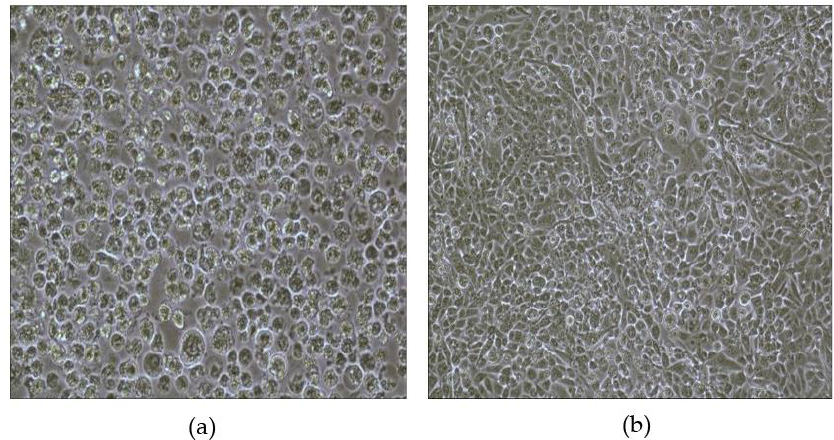
Figure 1. ( a ) RD cells with CPE; ( b ) normal RD cells; absence of CPE testified the positive result of EV71 neutralizing antibodies; multiplicative inverse of the highest dilution level without the presence of CPE was the determined point of EV71 neutralizing antibody titre.